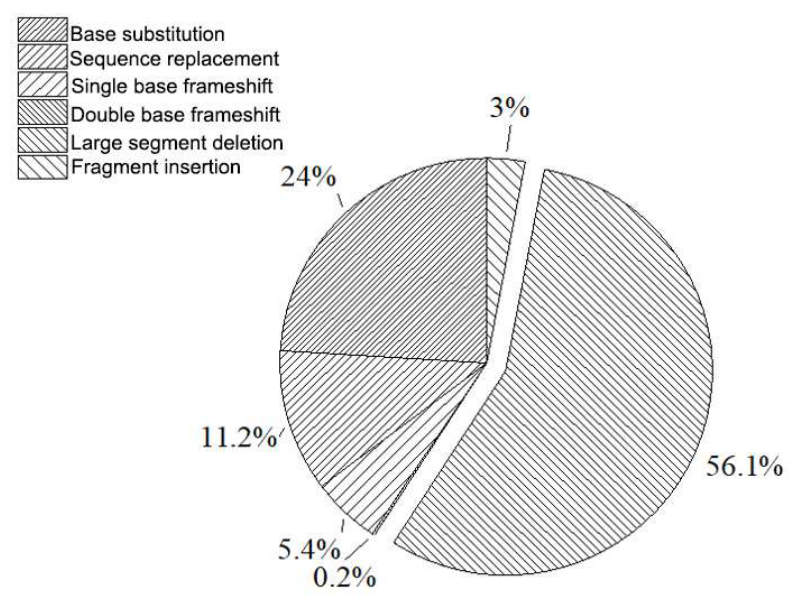
Figure 3. Statistics of spontaneous mutation types of rpsL .